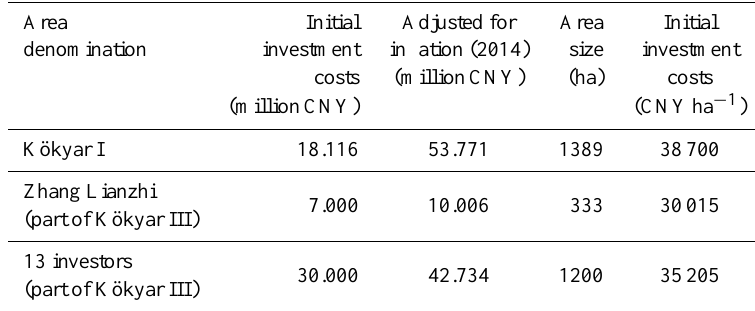
Table 3. Comparison of initial investment costs between Kökyar I and parts of Kökyar III, excluding costs of compulsory